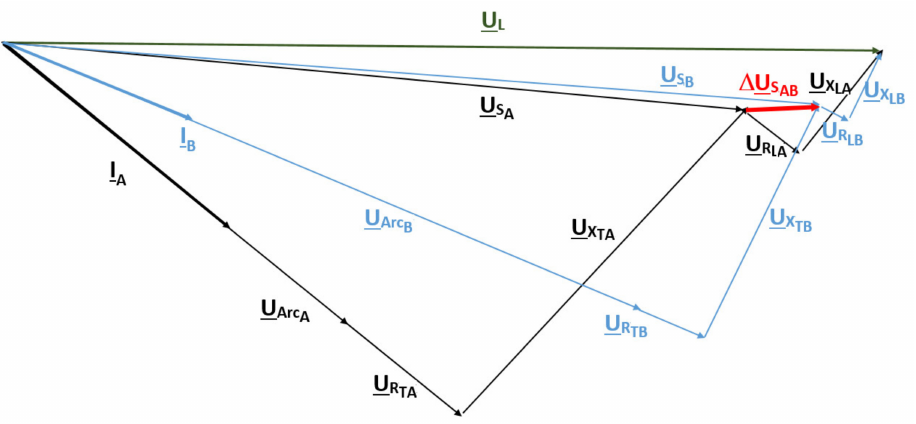
Figure 6. Vector diagram of the currents and voltages of the arc furnace. Based on the vector diagram of the arc furnace currents and voltages shown in Figure 4, U ArcA and U ArcB arc voltages can be calculated as: